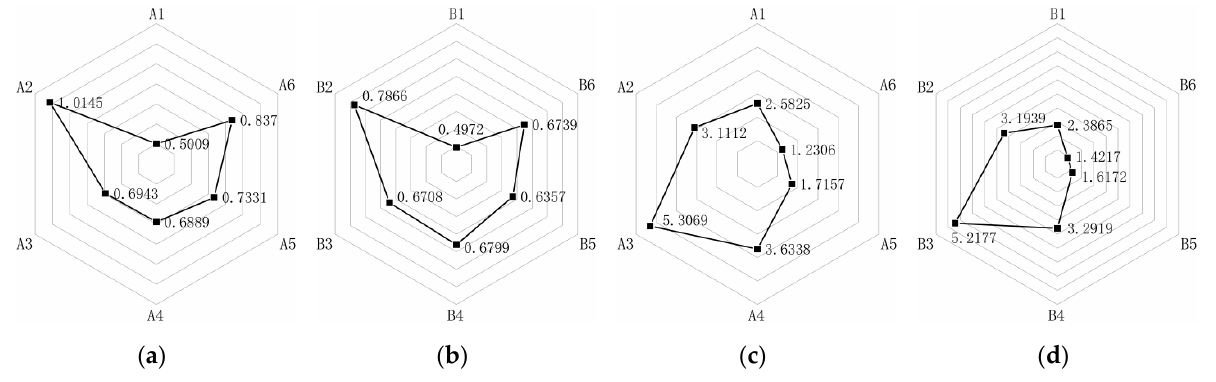
Figure 16. PPA (m/s 2 ) during single-train traffic: ( a ) PPHA of double-track tunnel; ( b ) PPHA of double-track tunnel with middle partition wall; ( c ) PPVA of double-track tunnel; ( d ) PPVA of double-track tunnel with middle partition wall; A1–A6 and B1–B6 here correspond to that of A1–A6 and B1–B6 in Figure 9.